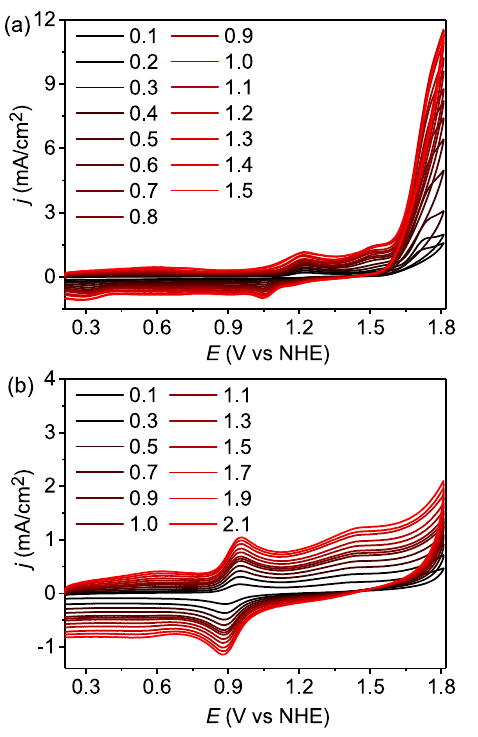
Fig. 4 Electrochemistry under acidic conditions. a CVs of Ru-bds in pH 1.0/CH 3 CN at different scan rates from 0.1 to 1.5 V s − 1 . b CVs of Ru-bda in pH 1.0/CH 3 CN at different scan rates from 0.1 to 2.1 V s − 1 . Note: i cat values at 1.78 V were used to calculate the TOF for both Ru-bds and Ru-bda .